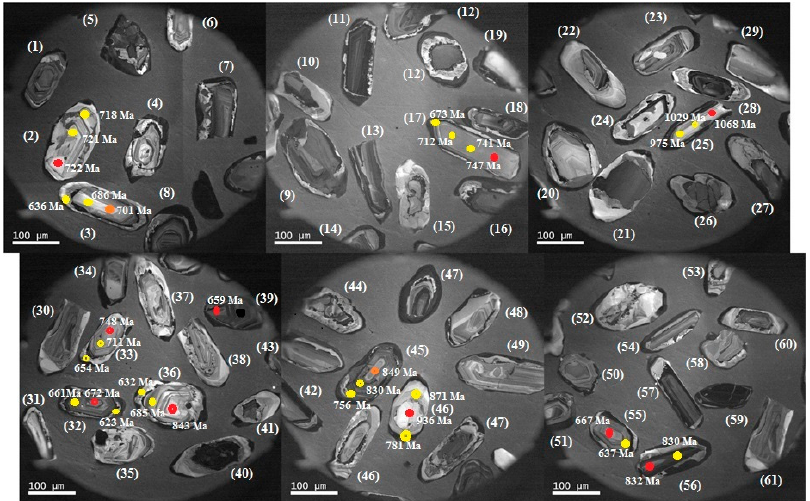
Figure 5. BSE-CL images showing internal texture of zircon crystals with analyzed spots (from Mboifong migmatite).